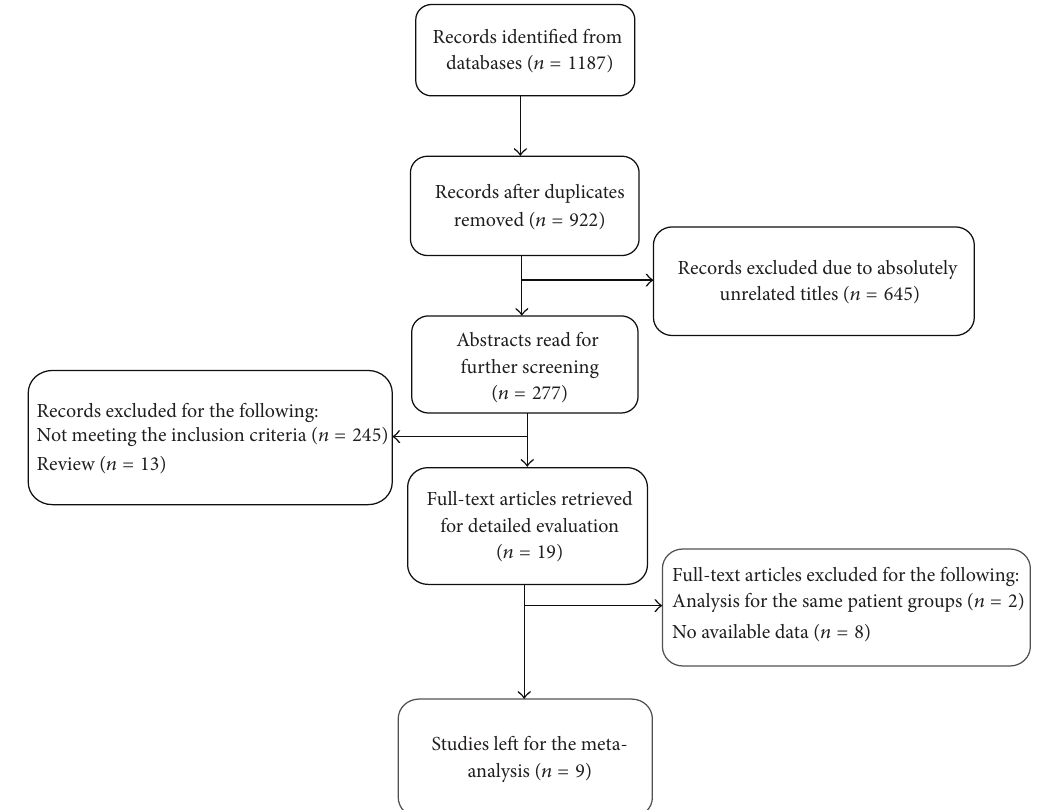
Figure 1: Flow diagram of literature selection